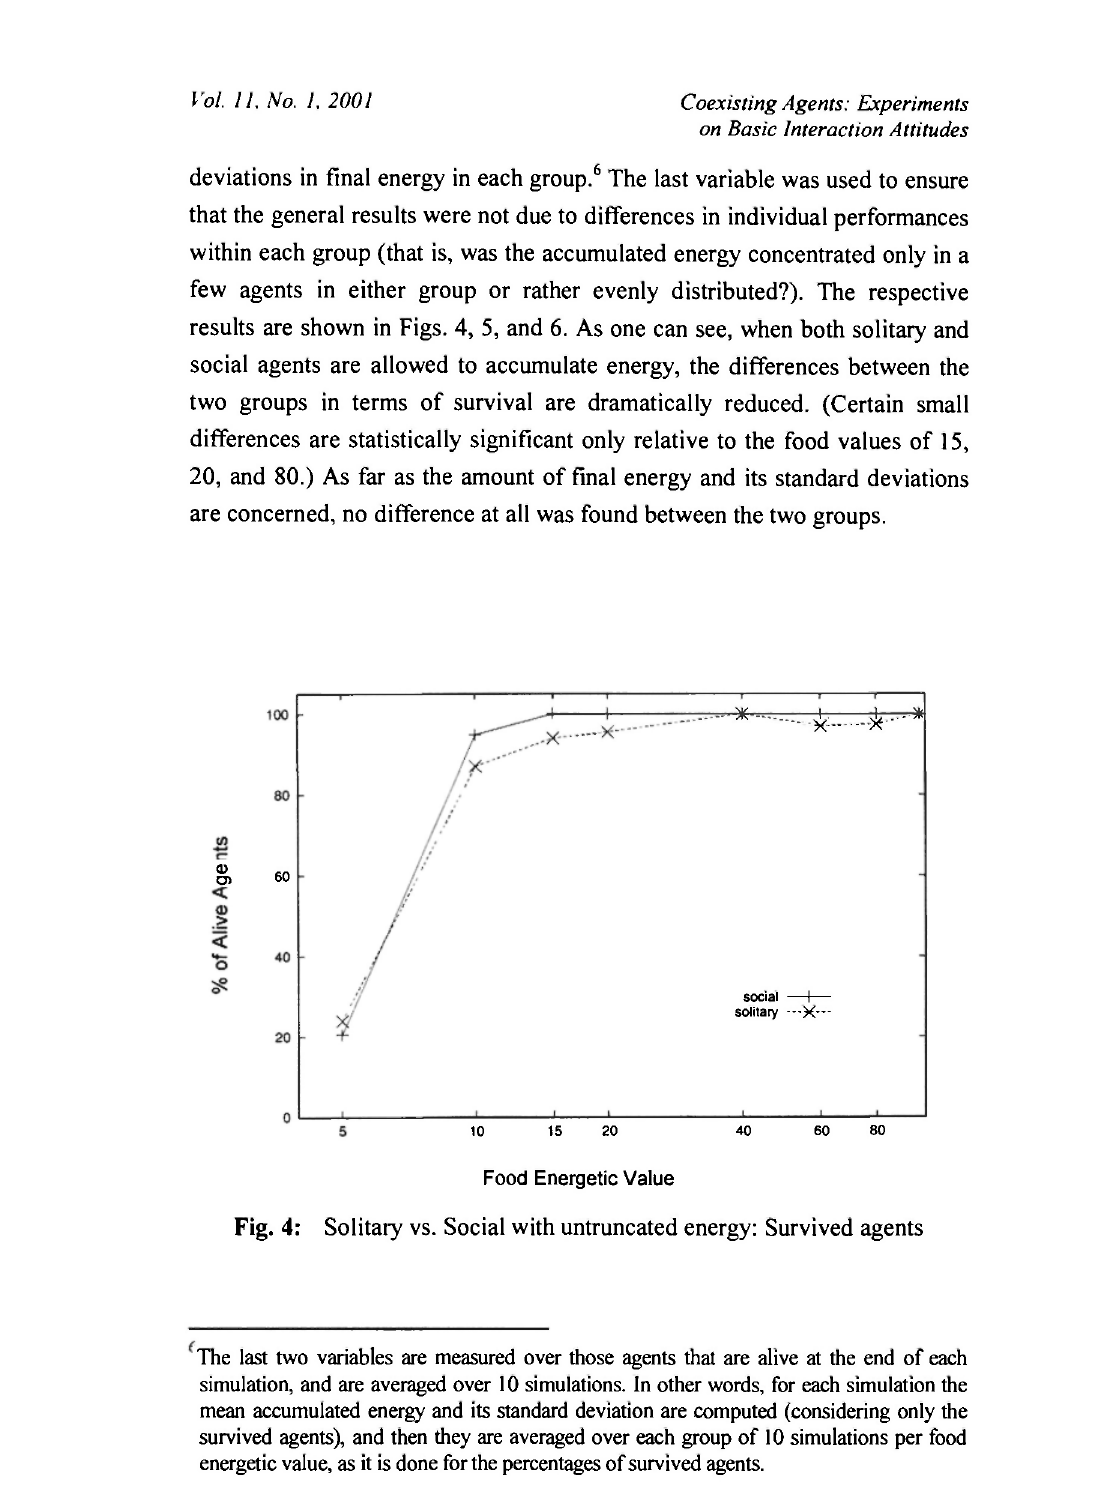
Fig. 4: Solitaiy vs. Social with untruncated energy: Survived